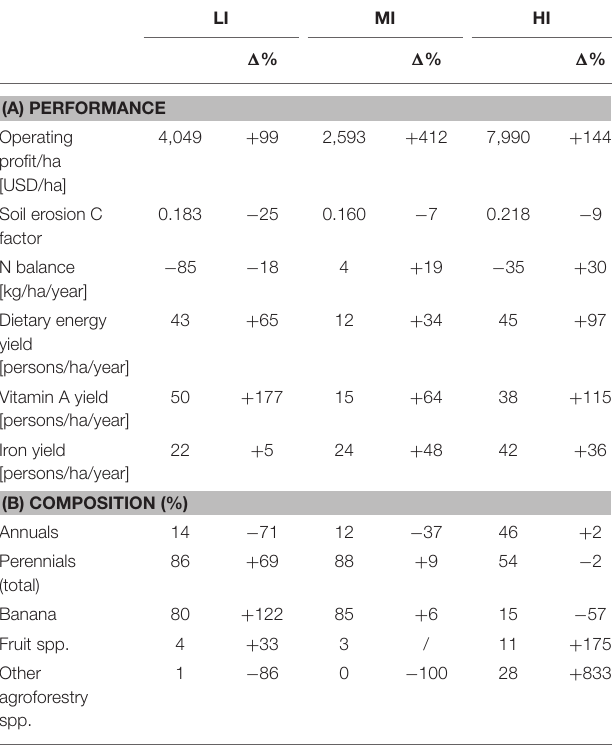
TABLE 3 | Performance ( A ) and composition ( B ) of the best redesigns for each farm type, as calculated by the FarmDESIGN model, and the percentage change in objective ( A ) and farm components ( B ) relative to the original farm